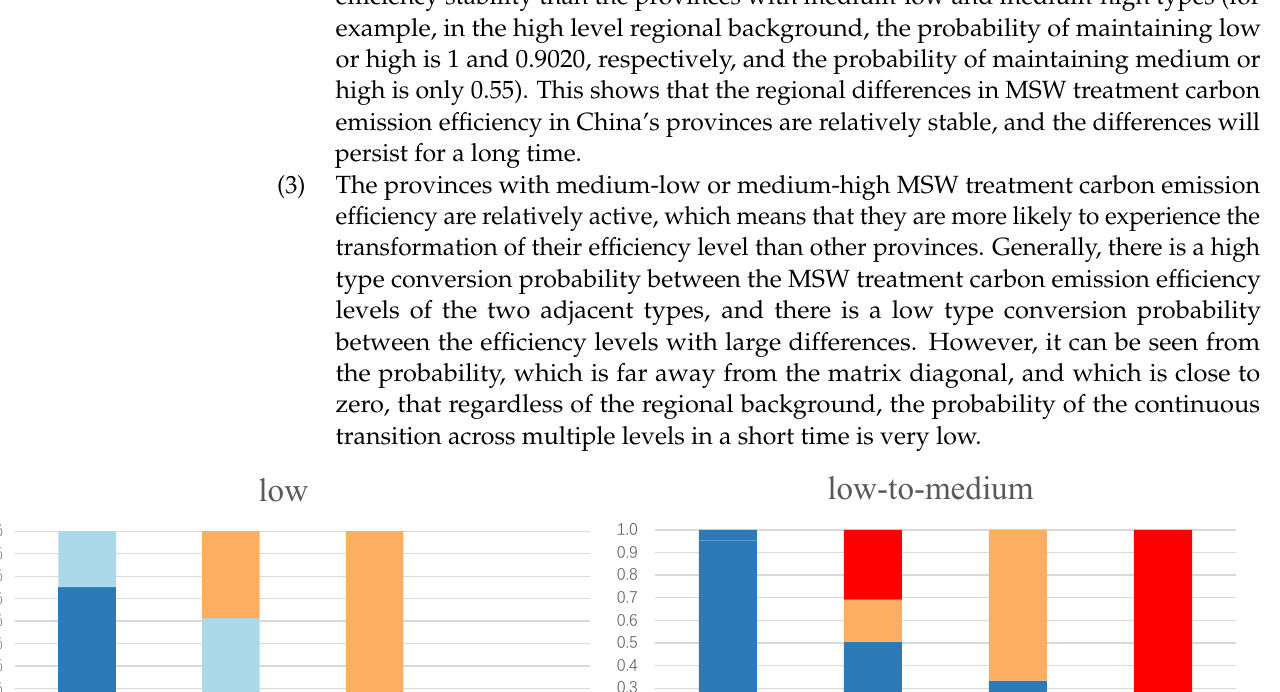
Figure 5. Markov transition matrix of the MSW treatment carbon emission efficiency in China dur- ing 2010–2019.